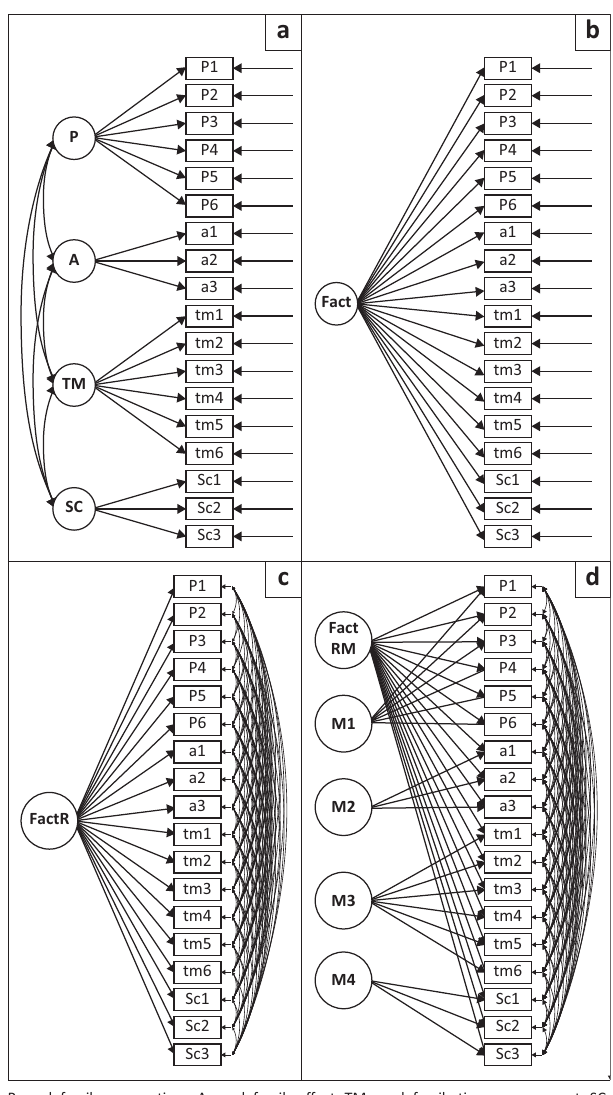
FIGURE 1: Models of the MACE work-to-family enrichment scale tested. (a) 4-factor; (b) 1-factor; (c) 1-factor R ; (d) 1-factor RM